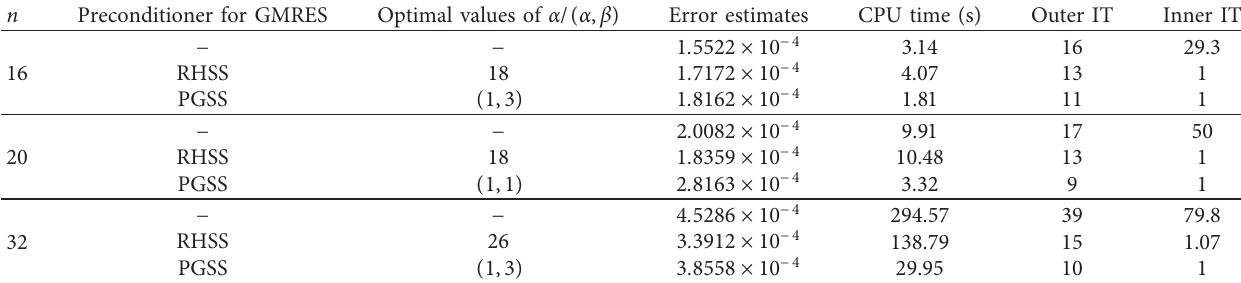
Table 10: Numerical results of preconditioned inexact Newton methods for v � 1 and η � 0.4.